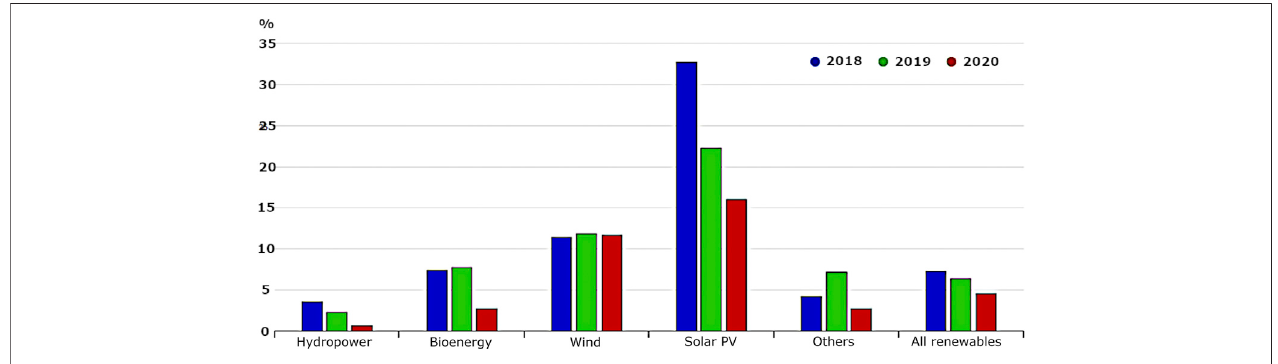
FIGURE 1 | Annual growth for renewable electricity generation by